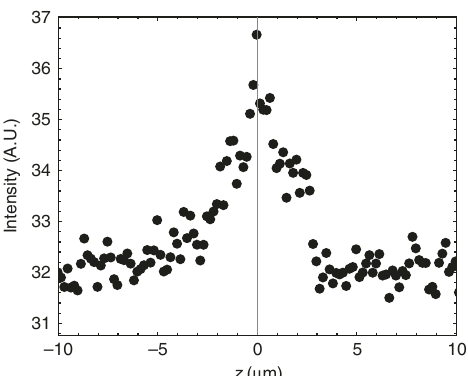
Fig. 2 Fluorescent signal measured across the cell in the presence of bullets. Nematic cell under an AC fi eld, U = 42.0 V, f = 200 Hz. Probing light polarized along the y -axis. The background fl uorescence signal from a cell at zero voltage is subtracted from the plot. d = 8.0 µ m, T = 35 °C. The maximum intensity observed at the middle plane, z = 0, indicates that the bullets propagate through the middle of the nematic slab